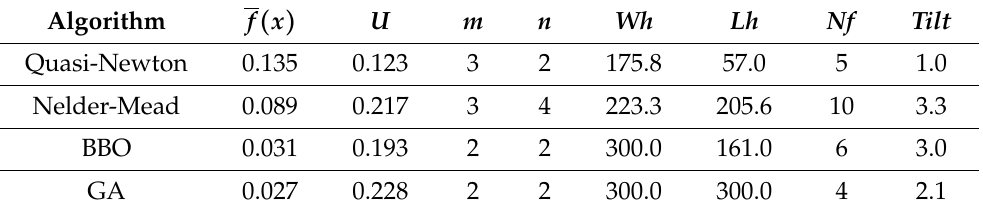
Table 6. Summary of optimization results.